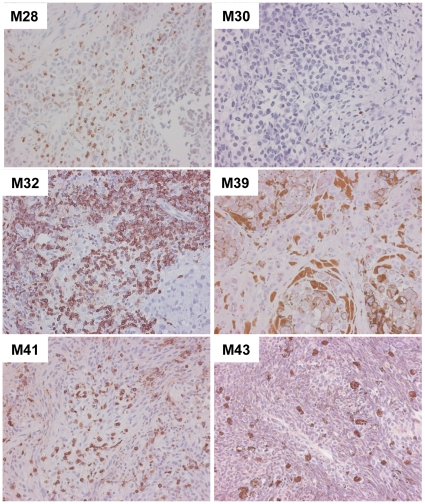
Immunohistochemistry for CD3.A piece of each tissue specimen from which TIL culturing was attempted was stained for CD3. Left column: dense TIL infiltration in representative tissue specimens that yielded robust TIL growth in vitro (M28, M32, M41). Right column: paucity of TILs in tissue specimens that yielded no or poor TIL growth in vitro (M30, M39, M43). Note that the dark staining in M39 is from pigmented melanoma cells and melanophages and the dark staining in M43 is from melanophages. Original magnification: 20x.